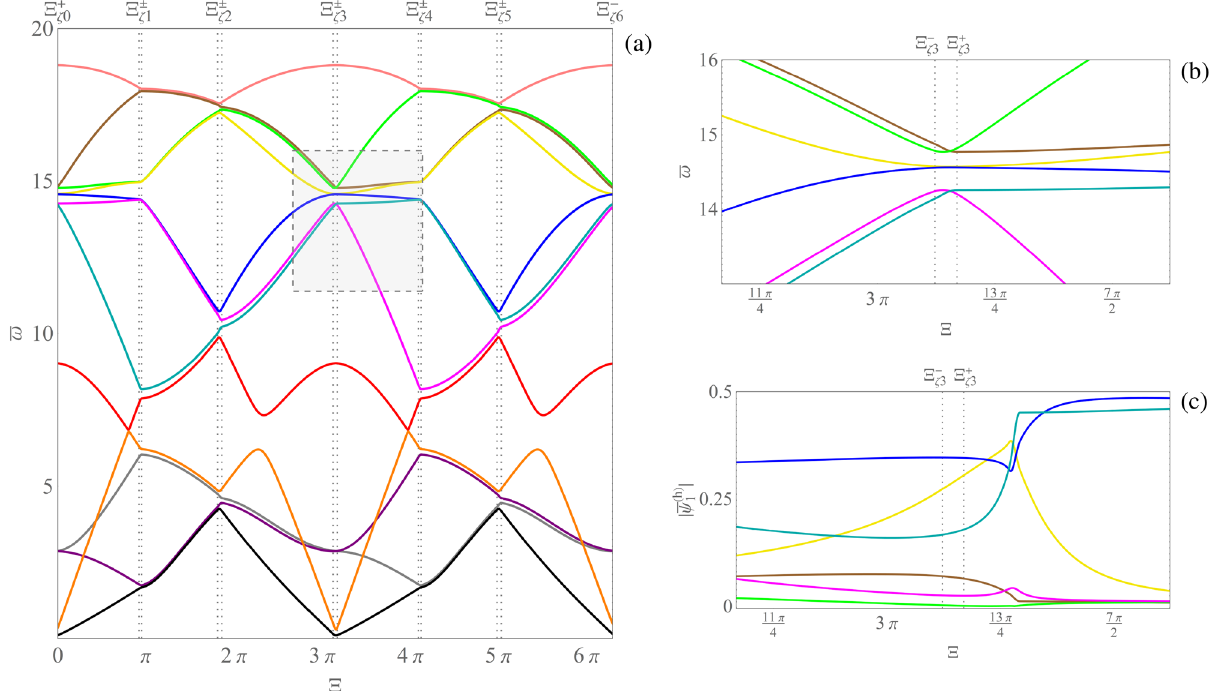
Figure 9. ( a ) Dispersion curve coloring obtained by Algorithm 1, in the case of the perturbed bi-triangular path; ( b ) zoomed view of the gray shaded area in part ( a ) of the figure; ( c ) magnitude components | ¯ ψ generalized eigenvector curves corresponding to the zoomed view shown in part ( b ) of the